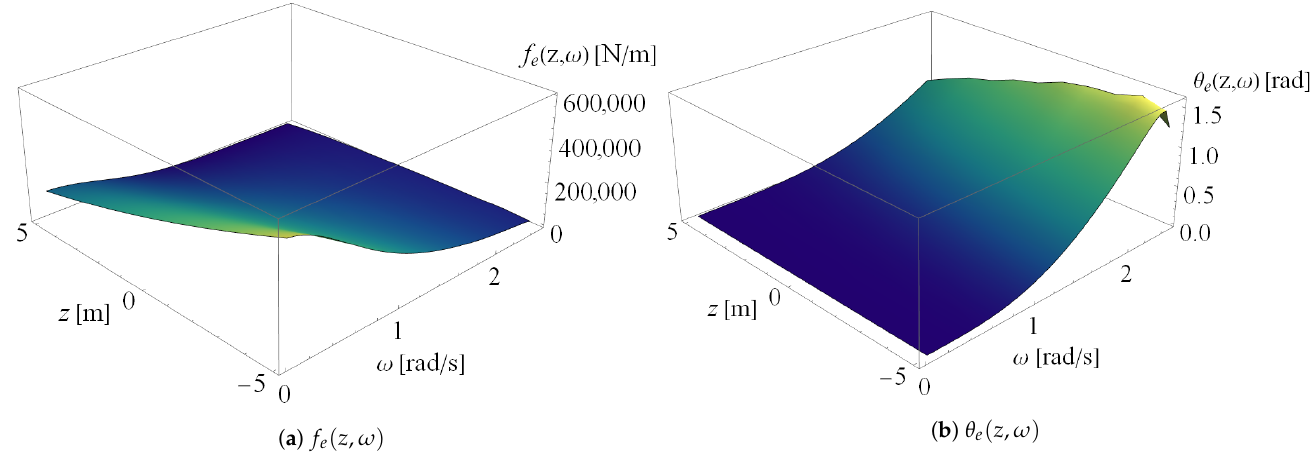
Figure 6. The wave excitation force ( a ) amplitude f e ( z , ω ) and ( b ) phase θ e ( z , ω ) , for the test case geometry. For this current test case, second-order polynomials are employed to approximate the wave excitation amplitude and phase as a function of the buoy position for each frequency, i.e.,